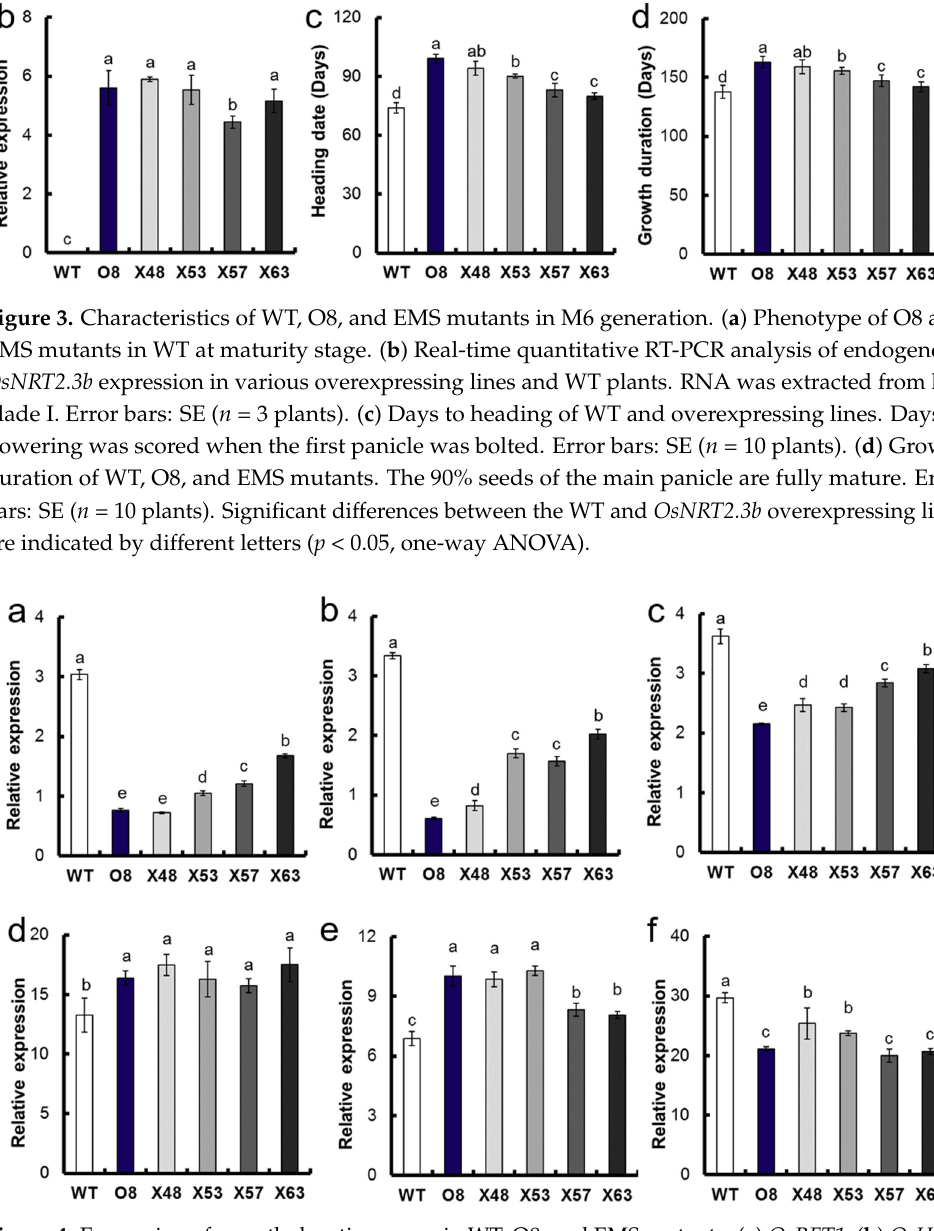
Figure 4. Expression of growth duration genes in WT, O8, and EMS mutants. ( a ) OsRFT1 , ( b ) OsHd3a , ( c ) OsEhd1 , ( d ) OsHd1 , ( e ) OsGI, and ( f ) OsLHY. RNA was extracted from leaf blade I. Error bars: SE ( n = 3 plants). Significant differences between the WT and OsNRT2.3b overexpressing lines are indicated by different letters ( p < 0.05, one-way